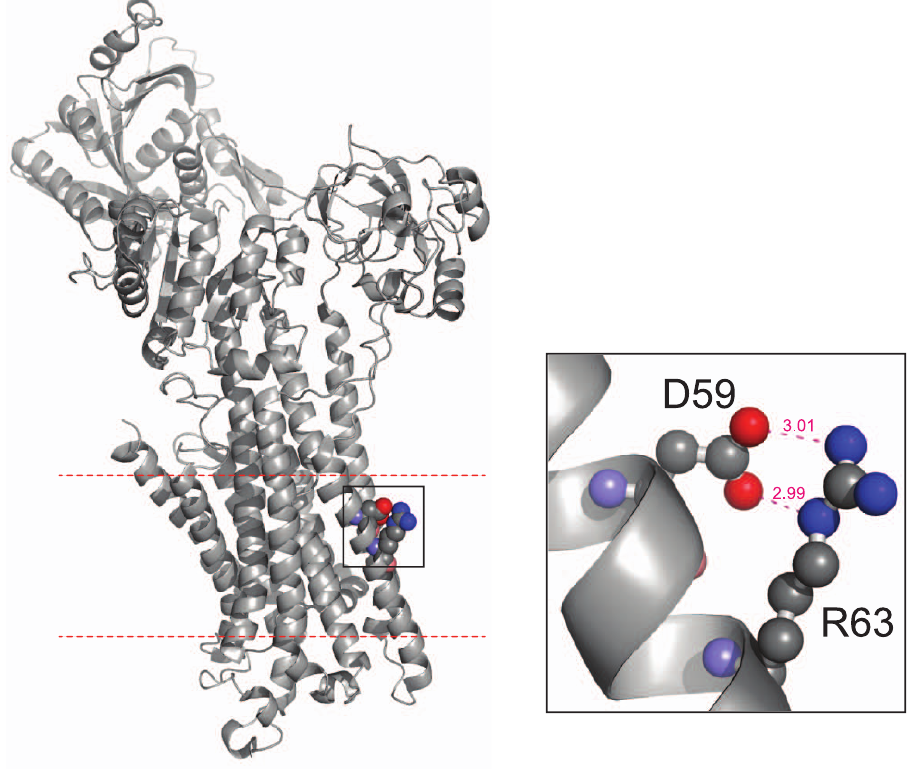
Figure 2. Structure of the calcium ATPase 1. Left panel: cartoon representation of sarcoplasmic/endoplasmic reticulum calcium ATPase 1 (PDB ID: 1SU4) with cytosolic domain in the up side and transmembrane aspartic 59 and arginine 63 residues in spheres representation (C atom gray, O atom red and N atom blue). Membrane boundaries (dashed red lines) were obtained from the PPM Server [44]. Right panel: zoom view centered on the salt bridge between Asp59 and Arg63, dashed pink lines indicate O to N atom